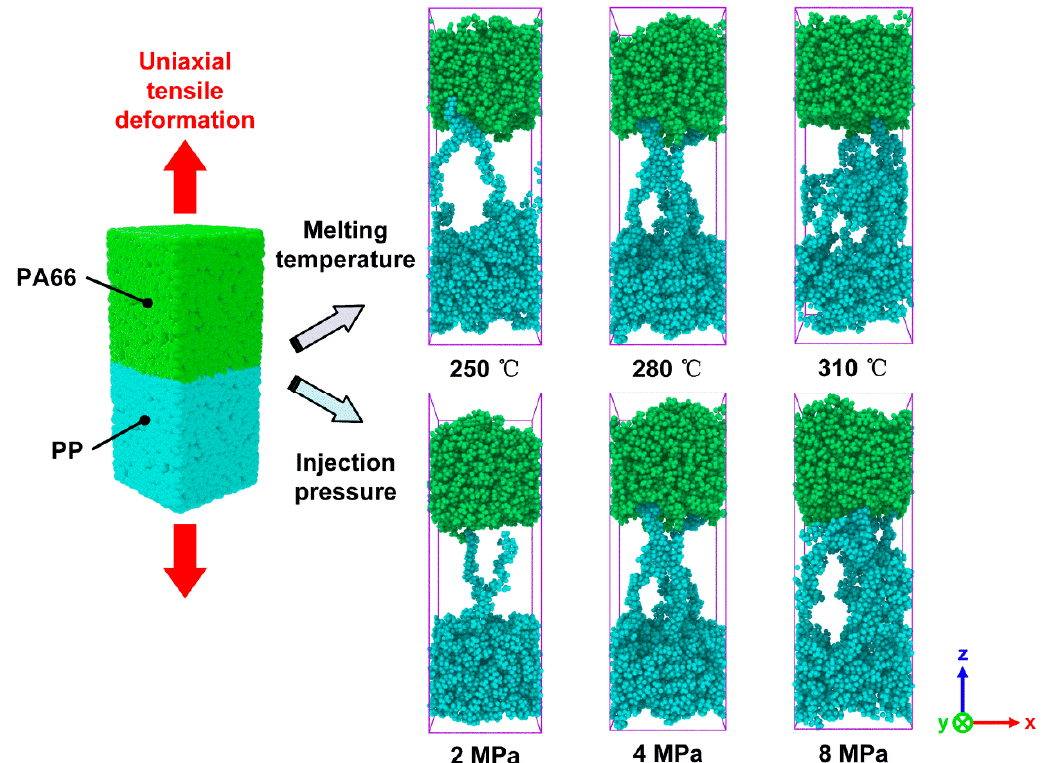
Figure 8. Snapshots of the damage modes in uniaxial tensile deformation of the combined PA66–PP interface under various processing parameters.